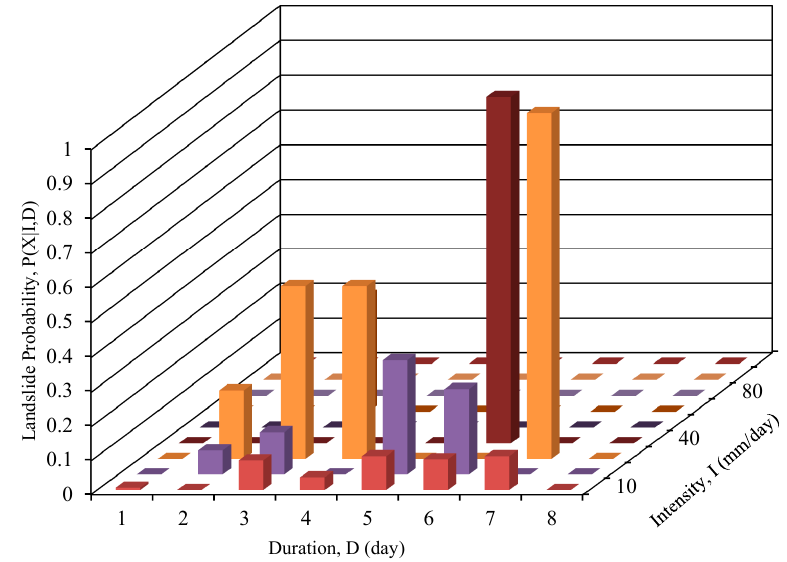
Figure 5. Two-dimensional probability considering rainfall intensity and rainfall duration parameters.